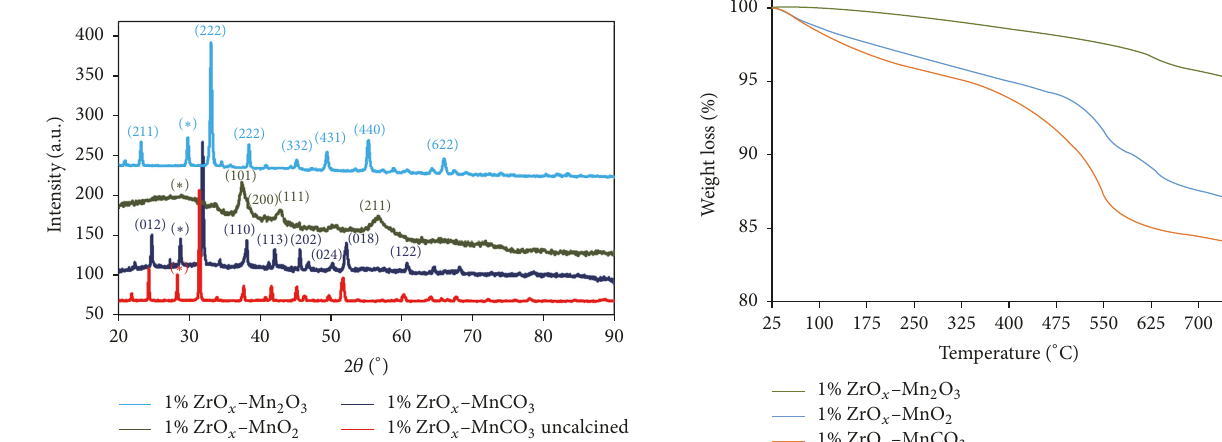
Figure 5: Thermogravimetric analysis of catalyst calcined at differ- ent temperatures 300 ∘ C, 400 ∘ C, and 500 ∘ C; 1% ZrO ZrO –MnO 2 ; and 1% ZrO x